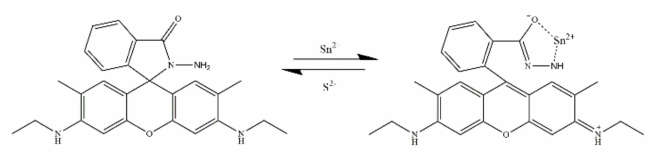
Figure 35. The possible sensing mechanism of Rh-Hyd (Table 1, No. 45) to Sn 2+ [70].